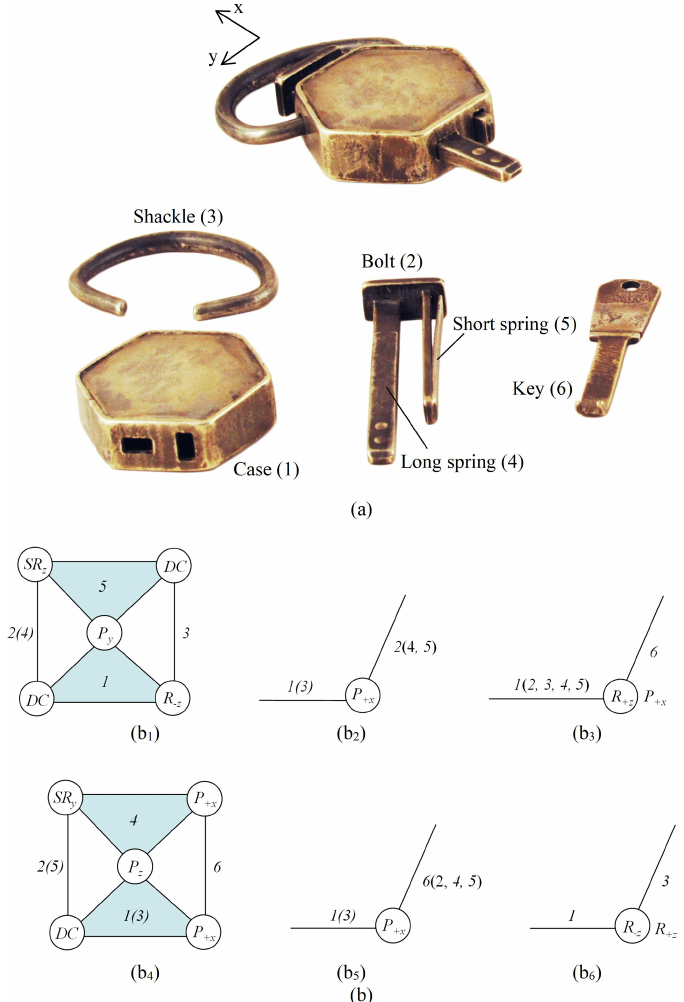
Figure 9. Copper padlock with pressing shackle – with two springs (Yi Zhi Tang Collection).